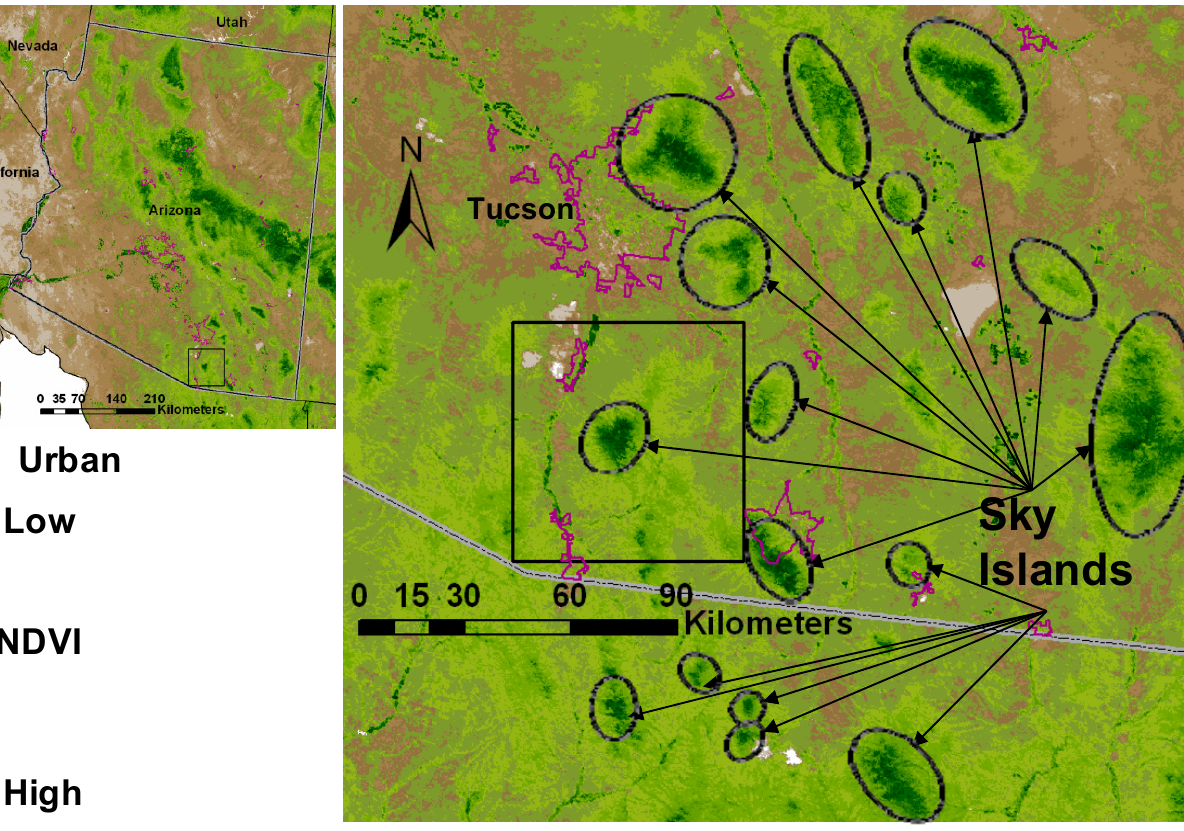
Figure 1. NDVI image of Arizona with a focus on the Santa Rita Mountains (pointed to in black box) and surrounding sky islands (circled), which are part of the Madrean Archipelago. The study site is centered on the Santa Rita Mountains, in southeastern Arizona, USA. The higher NDVI (Date: June 2007) values make the sky islands contrast with the Sonoran Desert lowlands. Urban areas are found within the magenta